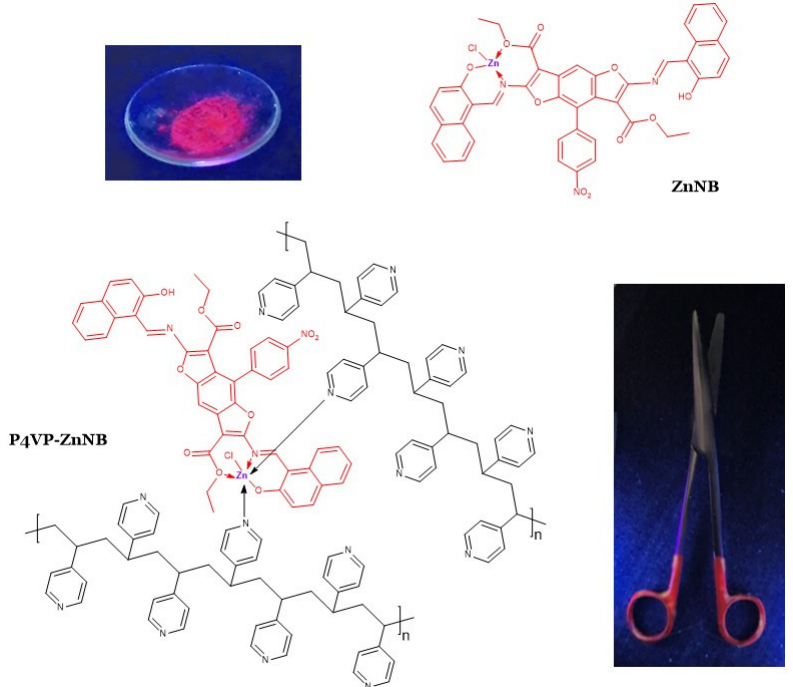
Scheme 1. Structural formulas of the coordination core (model ZnNB) and the polymer P4VP-ZnNB. In the insets: crystals of ZnNB core complex photographed under UV lamp at 365 nm (above,